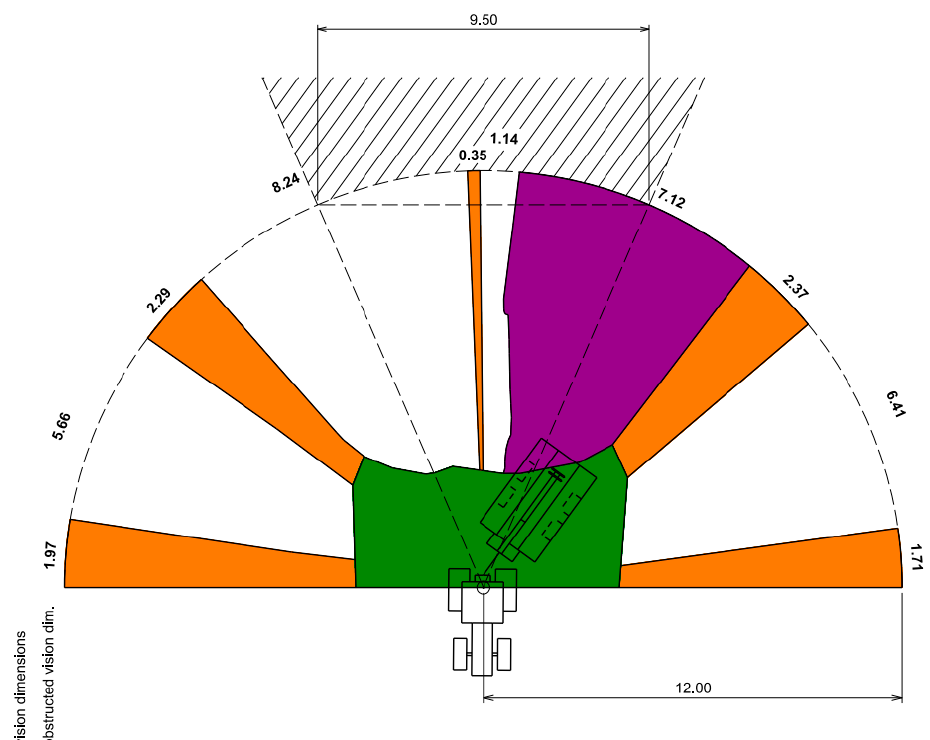
Figure 5. Graphical evaluation of the semicircular field of rear view from the cabin of tractor Valtra T 6300 with the coupled trailer STS 12T, rotated by 35° from the tractor axis. Table 1. Data on length and area characterizing the forward view of the driver of agricultural tractor. Tractor Valtra T 6300 Visible area Shaded